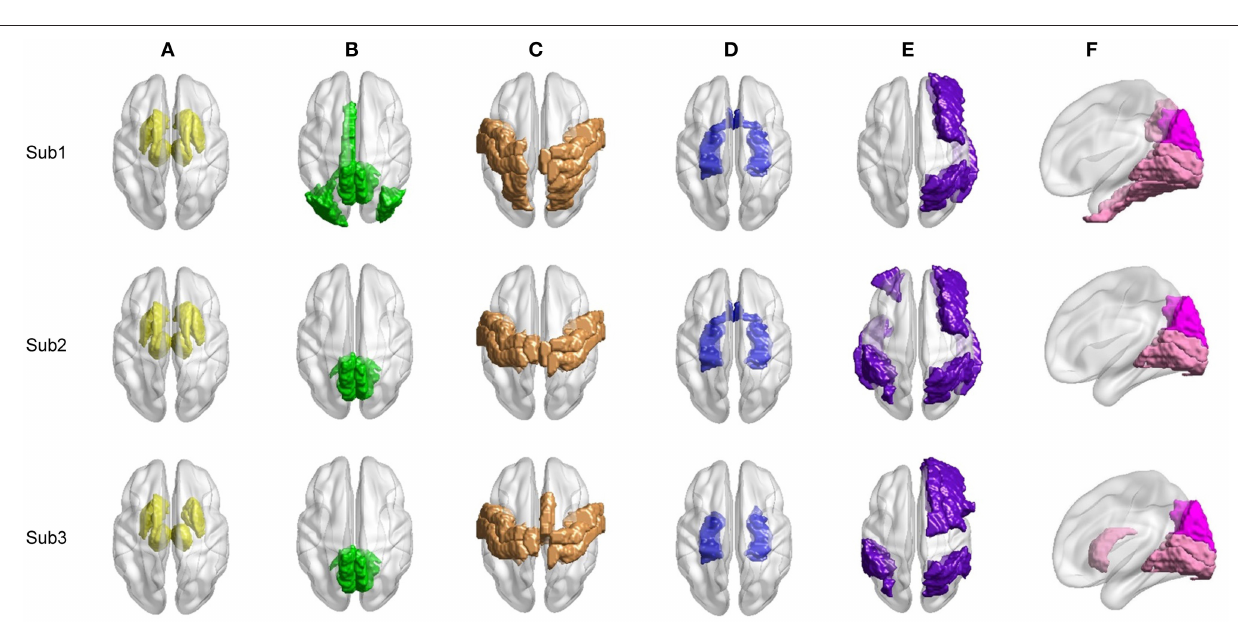
FIGURE 7 | Examples of six RSNs on three randomly selected subjects. (A) Basal ganglia. (B) Main parts of DMN including precuneus and PCC. (C) Sensorimotor cortex. (D) Limbic. (E) Frontal-parietal network. (F) Visual cortex including ventral visual and dorsal visual sub-networks. Regions marked in the same color belong to the same